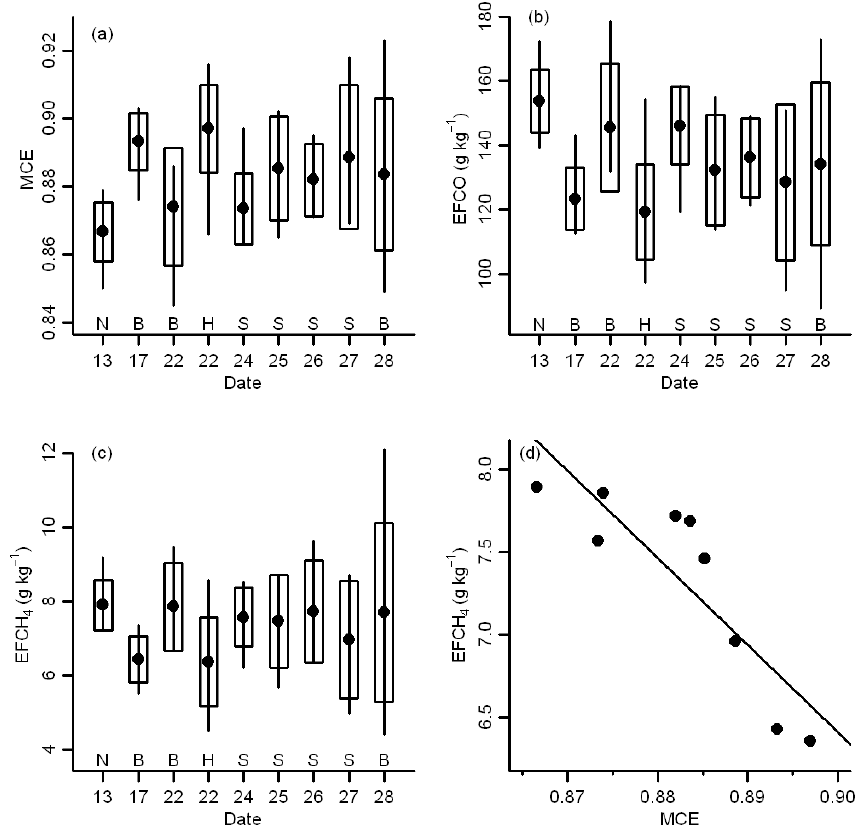
Fig. 3. (a) MCE, (b) EFCO, and (c) EFCH 4 by fire-day. The date is August 2011, N=North Fork prescribed fire, B=Big Salmon Lake Fire, H = Hammer Creek Fire, S=Saddle Complex. Solid circles are the fire-day average, boxes are ± 1 σ , vertical bars mark the minimum and maximum. (d) Fire-day average EFCH 4 vs. MCE. Solid line is linear least square fit: y = − 52.8 ×+ 53.9, r 2 = 0 . 76.